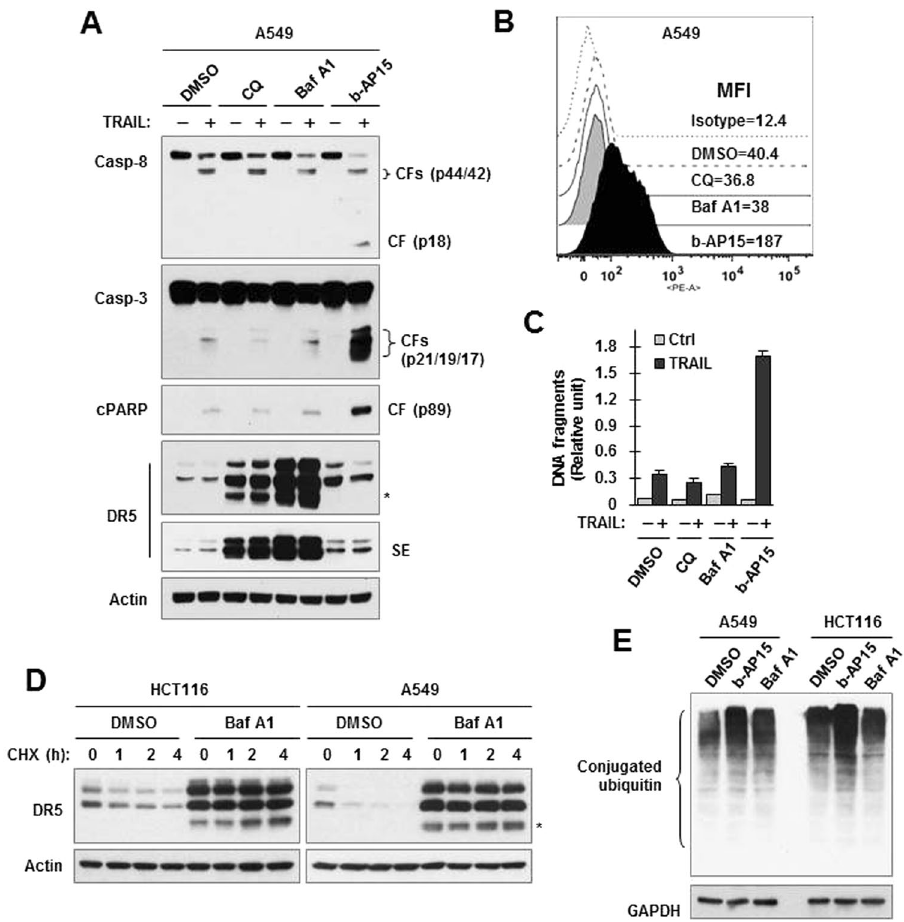
Figure 7. Inhibition of lysosome with both CQ and Baf A1 does not increase cell surface DR5 levels and protein polyubiquitinaiton ( B and D ) and enhances TRAIL-induced apoptosis ( A and C ) albeit potently elevating total cellular levels of DR5 ( C ) and increasing DR5 stability ( D ). ( A and C ) A549 cells were exposed to 20 μ M CQ, 50 nM Baf A or 1 μ M b-AP15 for 8 h and then co-treated with 200 ng/ml TRAIL for additional 4 h. ( B ) A549 cells were exposed to 20 μ M CQ, 50 nM Baf A or 1 μ M b-AP15 for 8 h. ( D) Both A549 and HCT116 cell lines were treated with DMSO or 50 nM Baf A1 for 5 h followed by the addition of 10 μ g/ml CHX. ( E ) Both A549 and HCT116 cell lines were exposed to DMSO, 1 μ M b-AP15 or 50 nM Baf A1 for 8 h. After the aforementioned treatments, the cells were harvested for preparation of whole-cell protein lysates and subsequent Western blotting ( A , D and E ), for cell surface DR5 detection with flow cytometry ( B ) or for detection of apoptosis with the Cell Death Detection ELISA Plus kit ( C ). The data are means ± SDs of triplicate determinations ( C ). SE, short exposure. The asterisk indicates an additional band lower than 40 kD. Full-length blots/gels are presented in Supplementary Figure